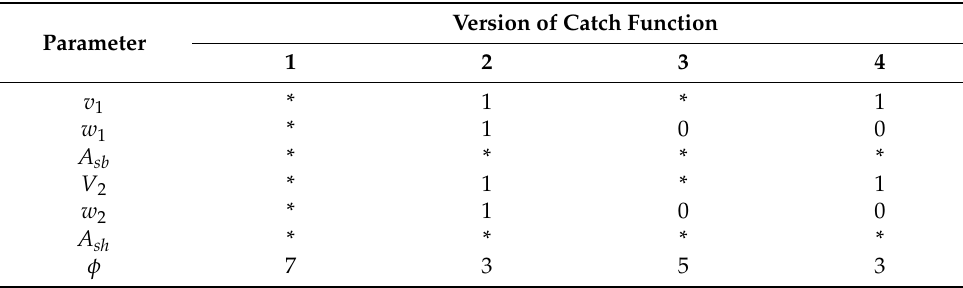
Table 1. Values for parameters according to the catch function assessed. Parameter